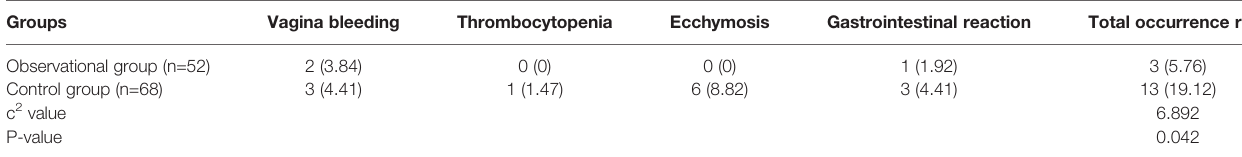
TABLE 6 | Occurrence of adverse reactions in the two groups (n, %).